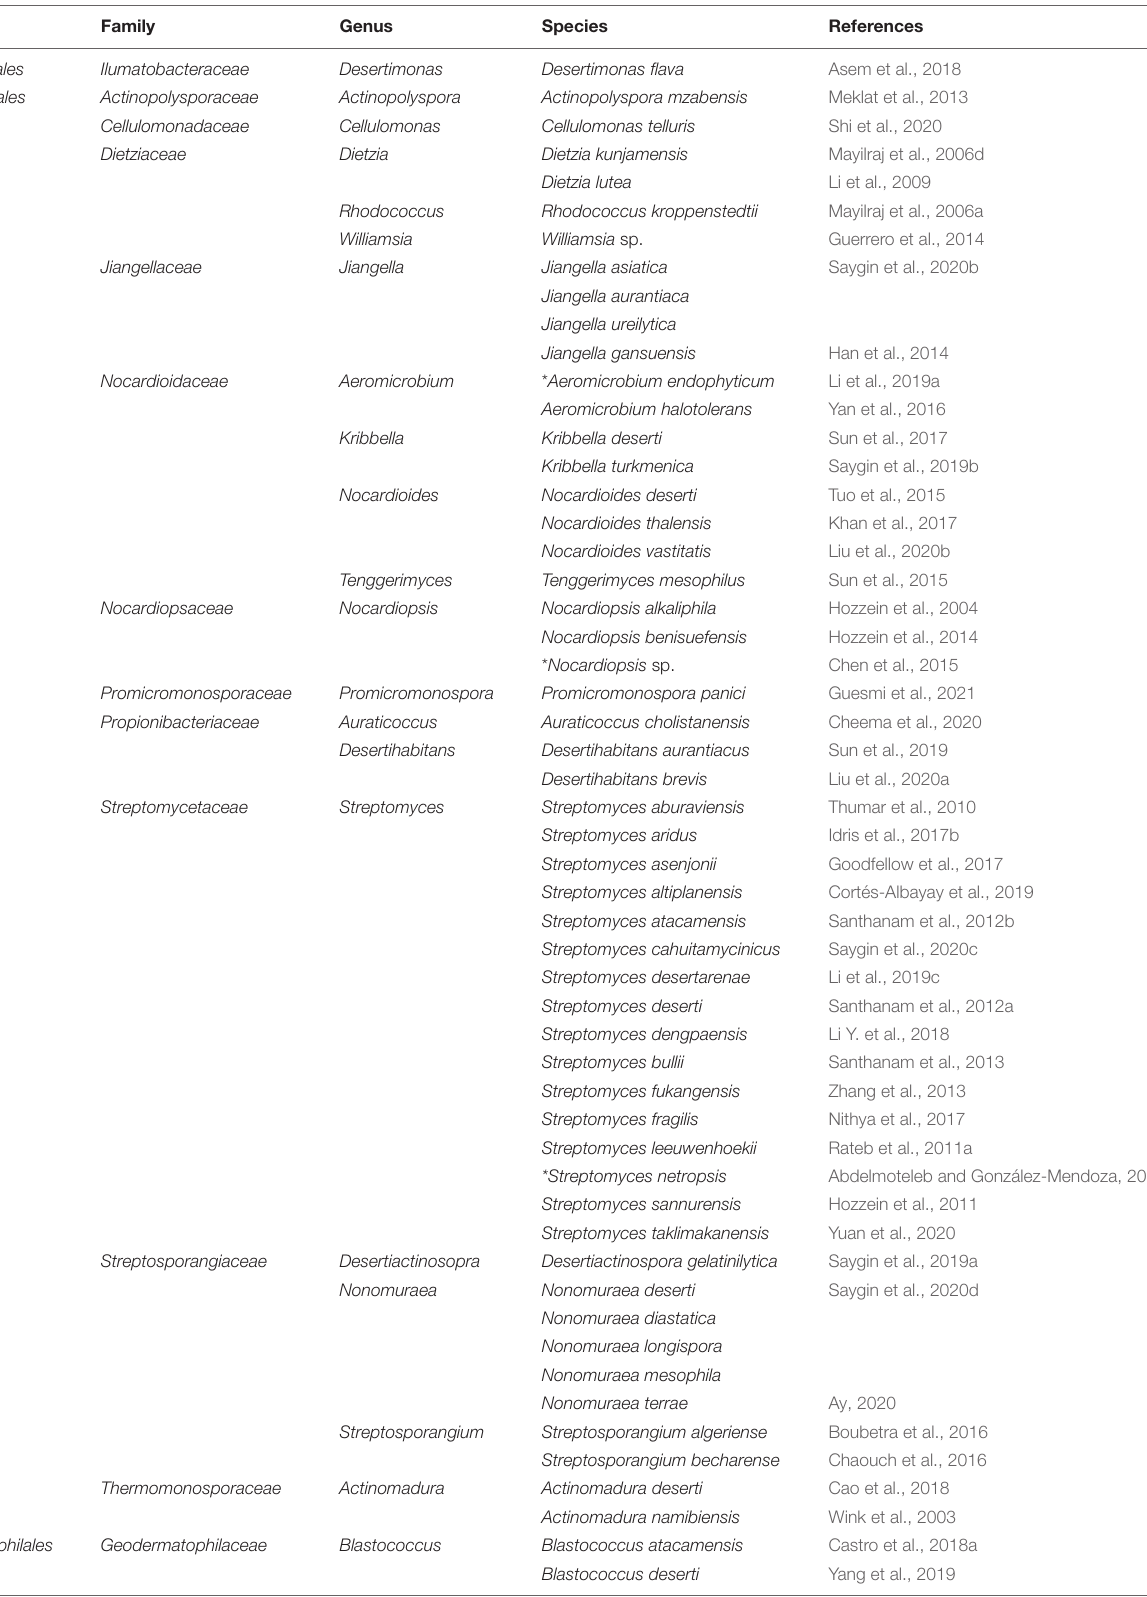
TABLE 1 | List of new actinobacteria isolated from desert environment from 2000 to